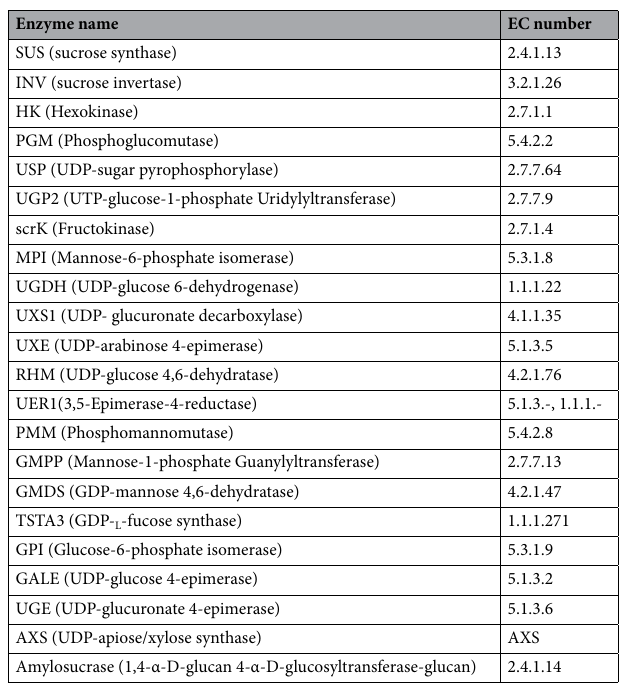
Table 3. Putative key enzymes involved in polysaccharide biosynthesis in P. grandiflorus